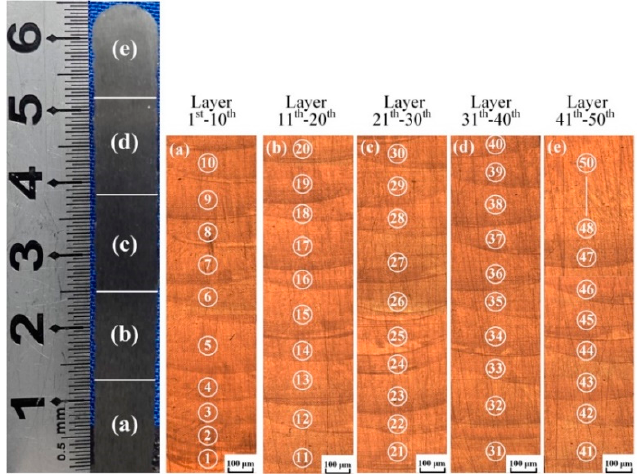
Figure 8. Macroscopic metallography of different layers in the middle section of specimen B: ( a ) layers 1–10, ( b ) layers 11–20, ( c ) layers 21–30, ( d ) layers 31–40, ( e ) layers 41–50.